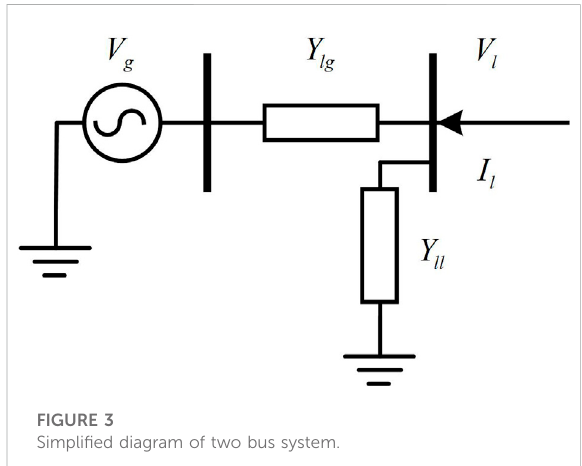
FIGURE 3 Simpli fi ed diagram of two bus system.